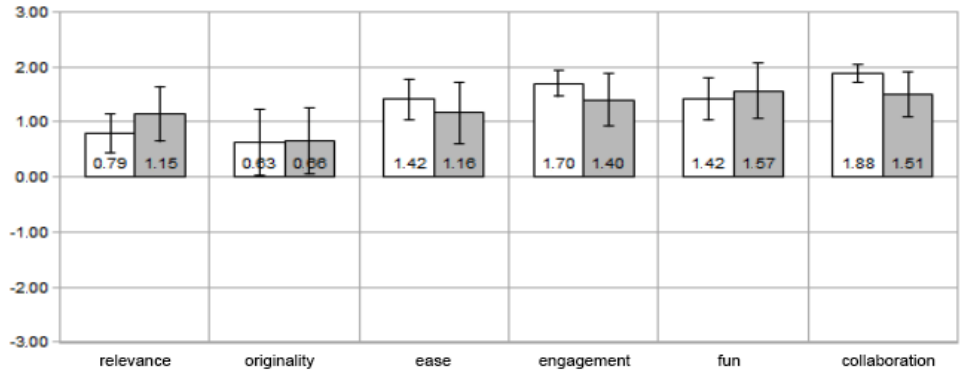
Figure 5 . Results with the time tagging metaphor using domestic sounds (for 108 interactions). Bars indicate average and lines represent the standard deviation for each creativity